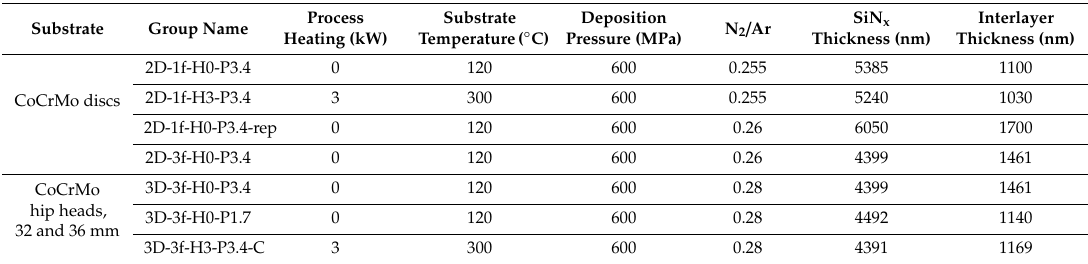
Table 1. SiN x coating deposition parameters of process heating, substrate temperature, deposition pressure, N 2 / Ar flow ratio and resulting layer